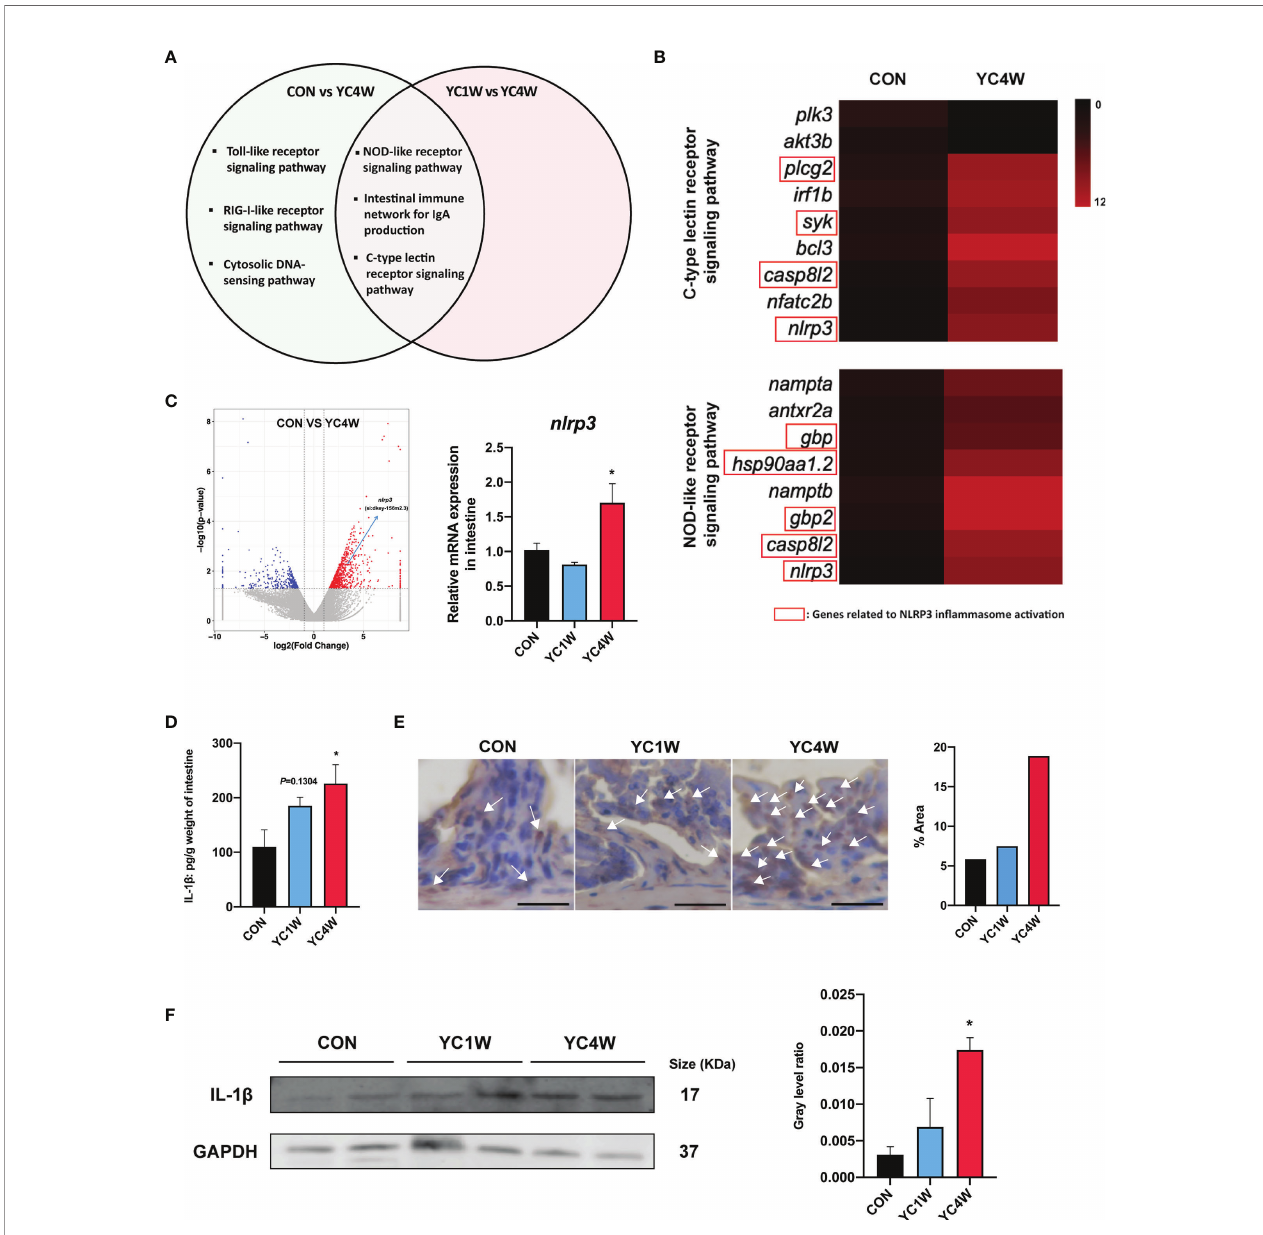
FIGURE 4 | P. pentosaceus YC contributes to NLRP3 in fl ammasome activation after a 4-week administration. Differentially expressed genes (CON vs . YC4W, YC1W vs . YC4W) of zebra fi sh intestine were analyzed and used for pathway classi fi cation based on KEGG enrichment analysis. (A) Immune-related pathways changed in both comparison CON vs . YC4W and YC1W vs . YC4W. (B) Heatmap of differentially expressed genes of C-type lectin receptor signaling pathway and NOD-like receptor signaling pathway in comparison to CON vs . YC4W. (C) Differentially expressed intestinal genes in comparison to CON vs . YC4W and relative nlrp3 mRNA quanti fi cation of zebra fi sh intestine by qPCR ( n = 6). (D) ELISA analysis of intestinal IL-1 b level of zebra fi sh from CON, YC1W, and YC4W groups ( n = 6). Representative (E) immunohistochemical and (F) Western blot analysis of intestinal IL-1 b of zebra fi sh from CON, YC1W, and YC4W groups. Scale bars represents 20 µm. Data are represented as mean ± SEM. * p < 0.05 by one-way analysis of variance followed by Dunnett ’ s multiple comparisons